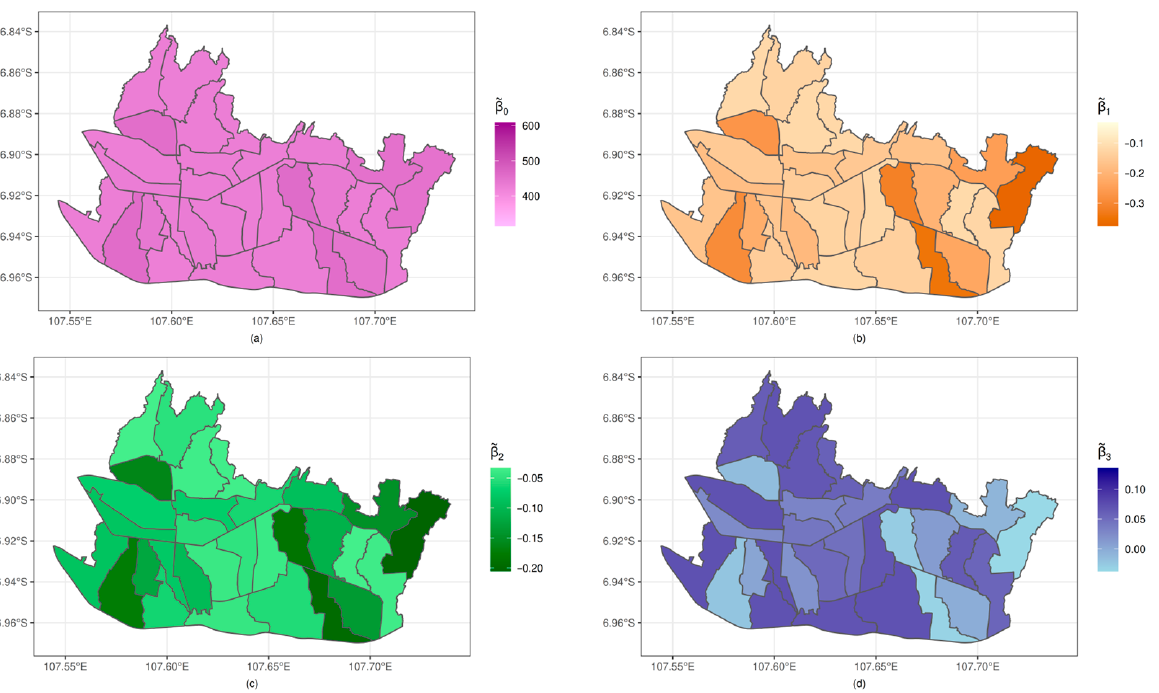
Figure 5. Coefficient maps of space variable for quantile 0.50 of dengue fever in Bandung city from 2017–2021 (( a ) for intercept, ( b ) for slope 1, ( c ) for slope 2, and ( d ) for slope 3).